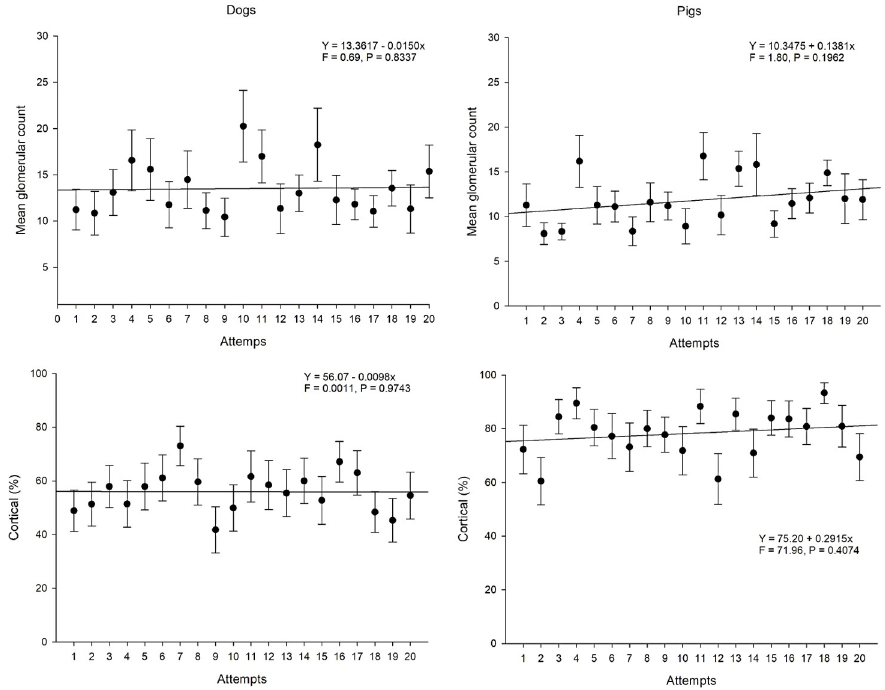
Fig 2. Mean glomerular count and cortical percentage of the kidney fragments collected by the operators throughout the study in the different species (canine and swine). (A) Mean glomerular count throughout the study attempts collected from dogs. (B) Mean glomerular count throughout the study attempts collected from pigs. (C) Mean kidney cortical percentage throughout the study attempts collected from dogs. (D) Mean kidney cortical percentage throughout the study attempts collected from pigs. The Y, F, and P values are indicated in each evaluation and show the presence (or not) of statistical differences of the variables considered for this figure among the attempts and between